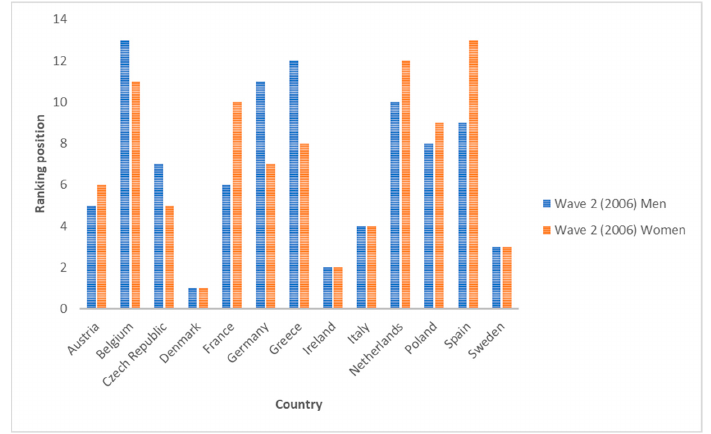
Figure 3. Position in the ranking of each country in Wave 2 (2006). Source: Authors’ elaboration based on SHARE (2021).